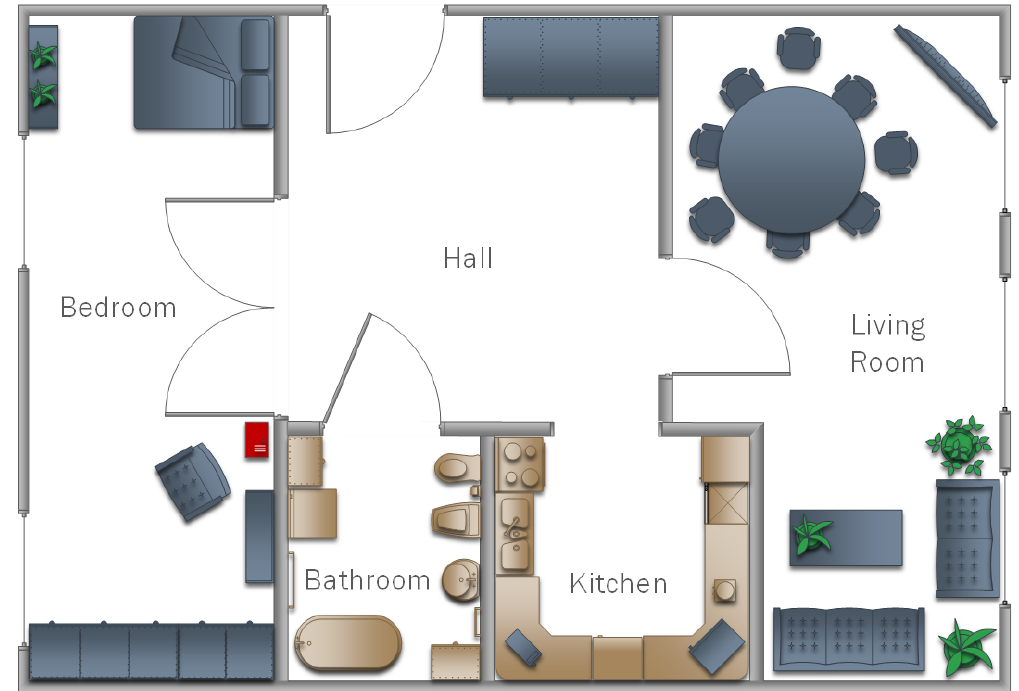
Figure 10. A model of the home that was used in testing proposed model in Experiment III.